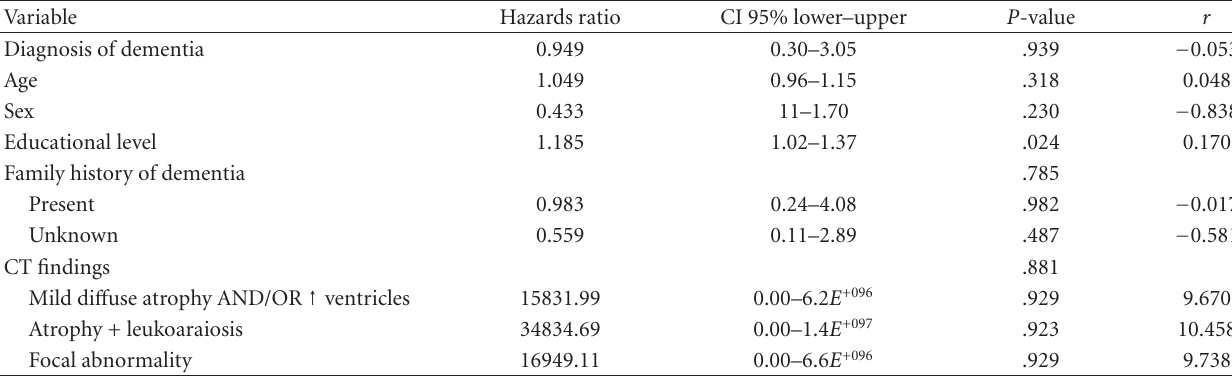
Table 2: Predictive factors in Cox Proportionate Hazards Models, including diagnosis of dementia, age, educational level, sex, family history of dementia, and CT scan findings, for the progression of dementia (worsening of severity according to CDR scale).